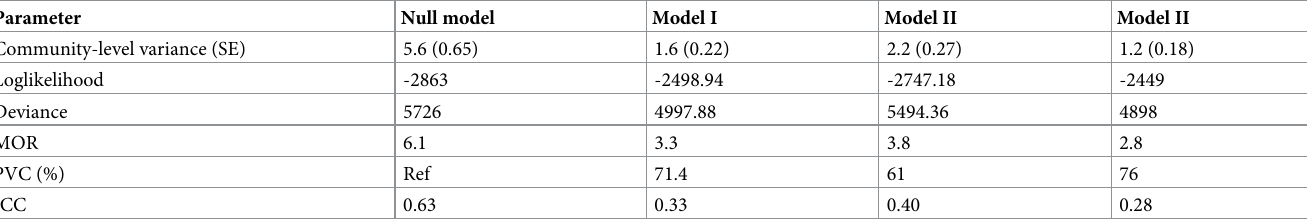
Table 2. Random effect analysis